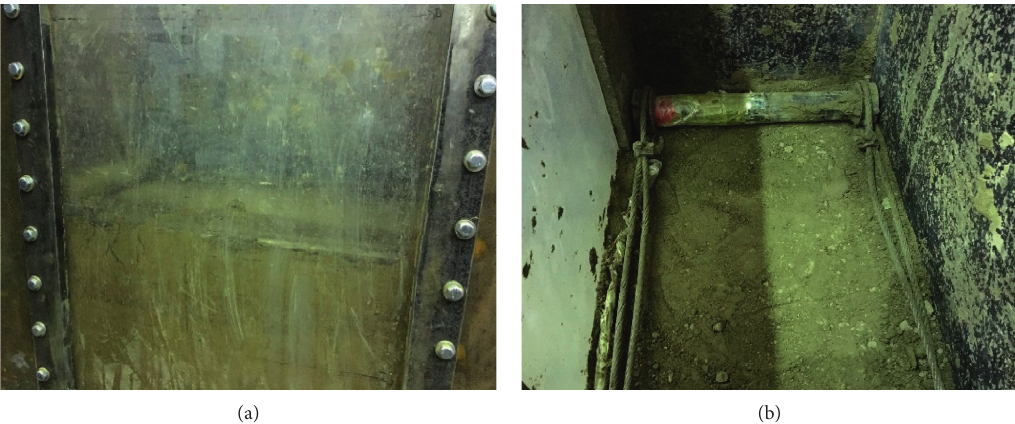
Figure 5: Place the test pipe at the designated position. (a) Side view of pipe placement. (b) Top view of pipe